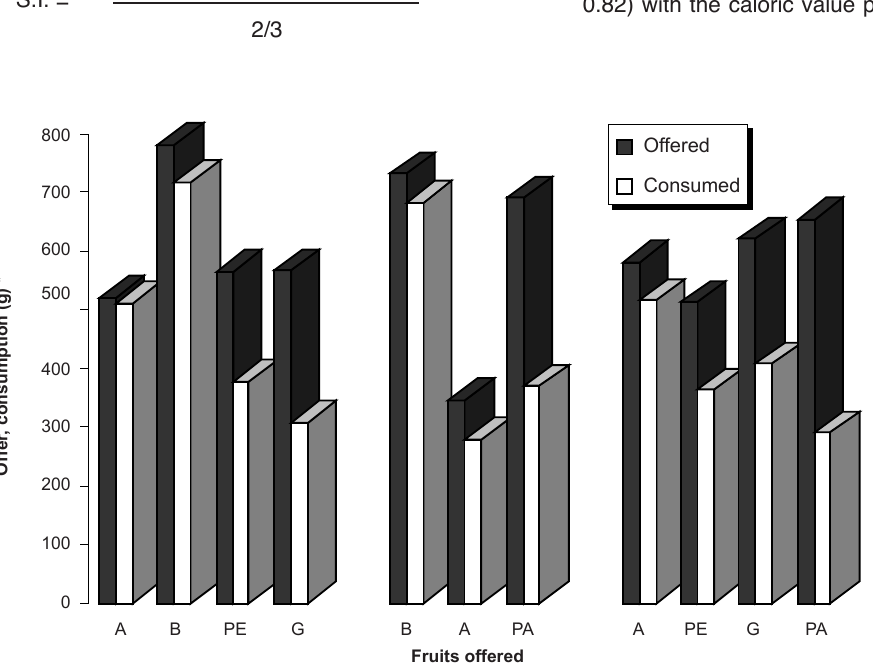
Figure 1. Fruit offer and fruit consumption of C. sphinx (n = 15) during two months in captivity. * - Three combinations of five different fruit offered; A - Apple; B - Banana; PE - Pear; G - Guava; PA -